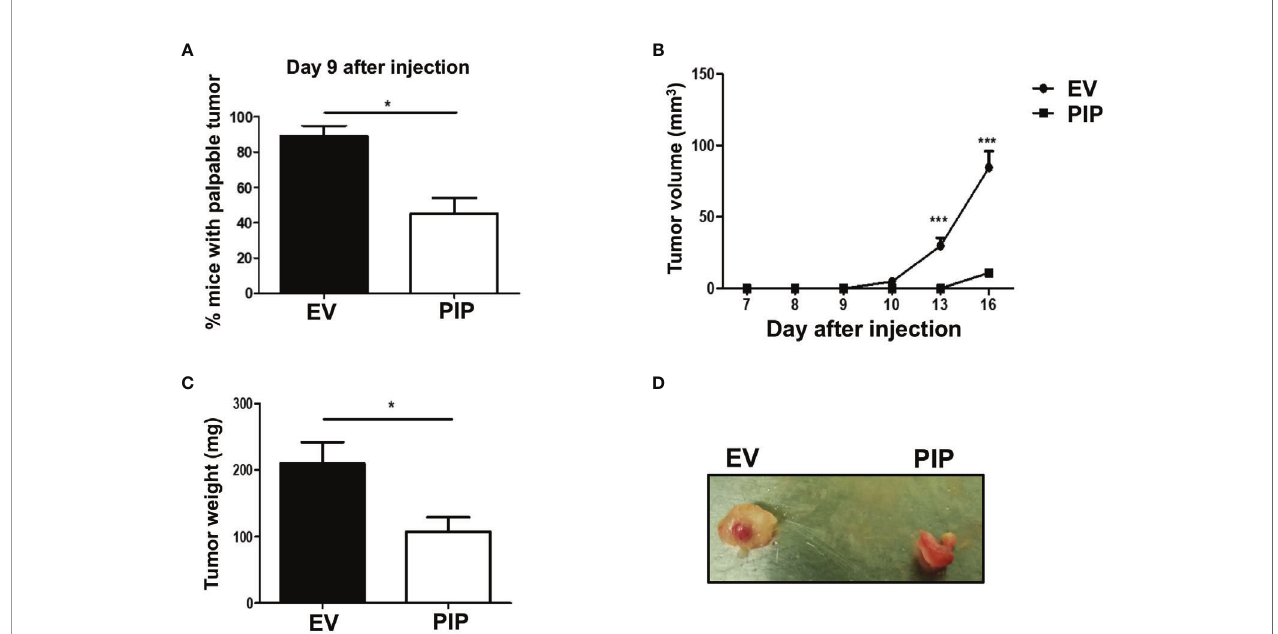
FIGURE 3 | PIP expression delays 4T1 tumor onset and growth in immunocompetent mice. Female WT BALB/c mice were injected orthotopically into the 4 th mammary fat pad with 1 × 10 4 4T1-EV (empty vector control) or 4T1-PIP (PIP expressing) cells in 100 m l PBS and the onset of palpable tumor (latency) was determined (A) . Thereafter, the growth curves were determined by measuring the tumor diameter daily with digital calipers (B). At sacri fi ce, the tumors were excised and weighed to determine the tumor size (C) and representative photo images of excised tumors were obtained (D) . Results are representative of three different experiments. Results are expressed as mean ± SEM of n = 3 – 5 mice/group. *p < 0.05; ***p < 0.001; T-test and two-way ANOVA were